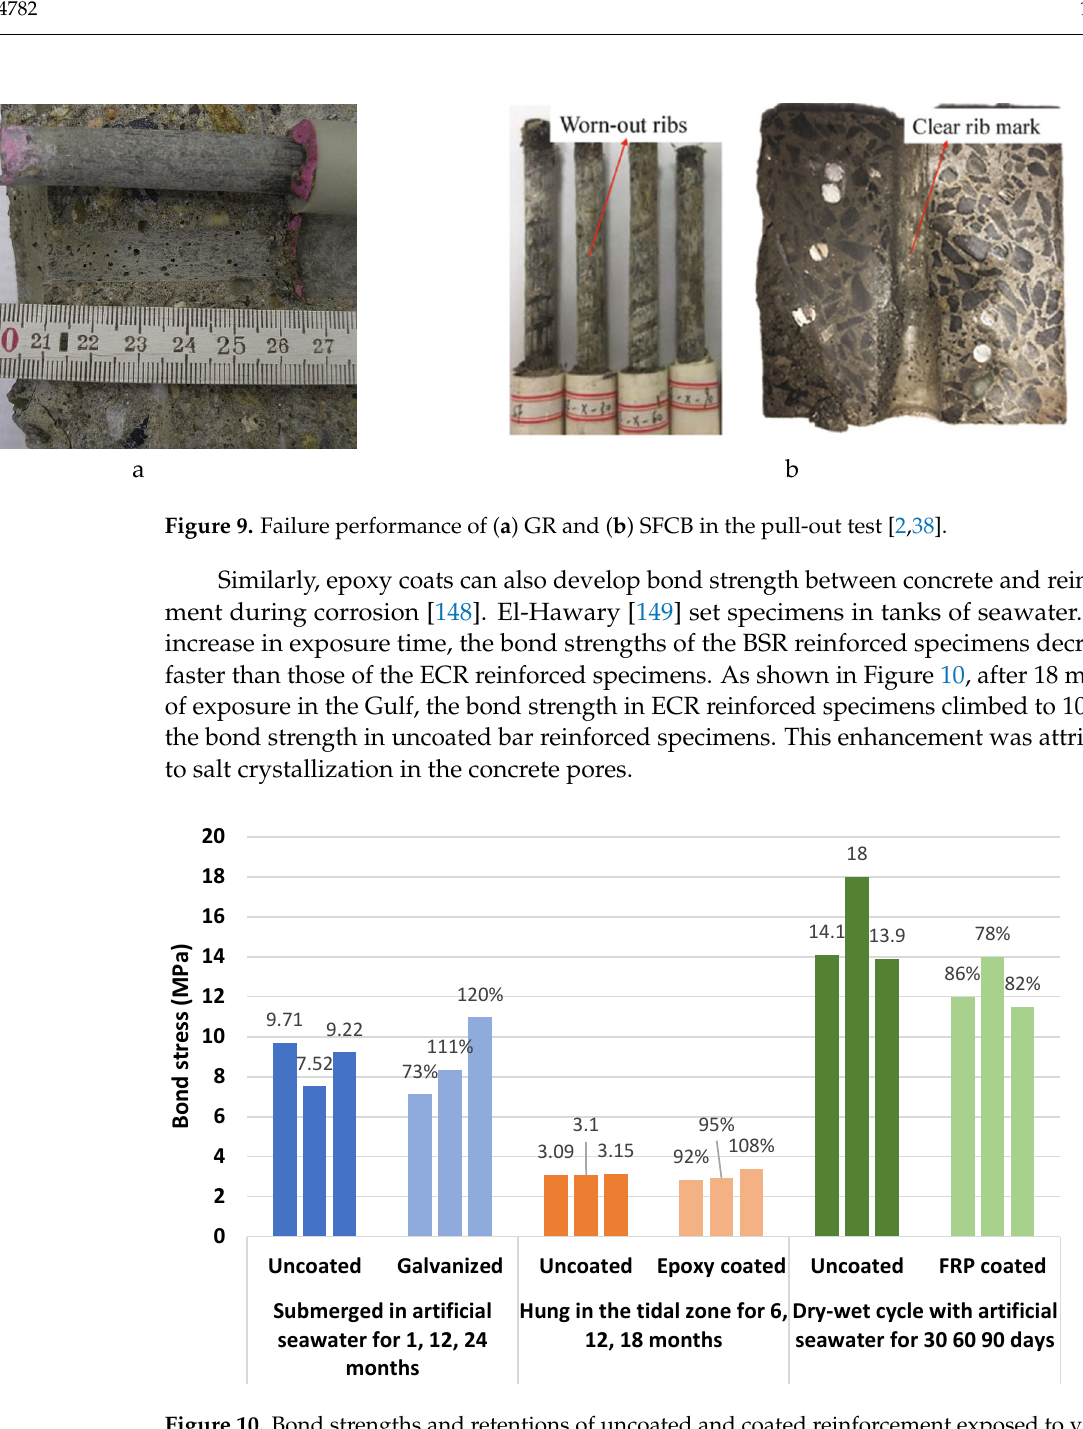
Figure 10. Bond strengths and retentions of uncoated and coated reinforcement exposed to varying environments [38,147,149].